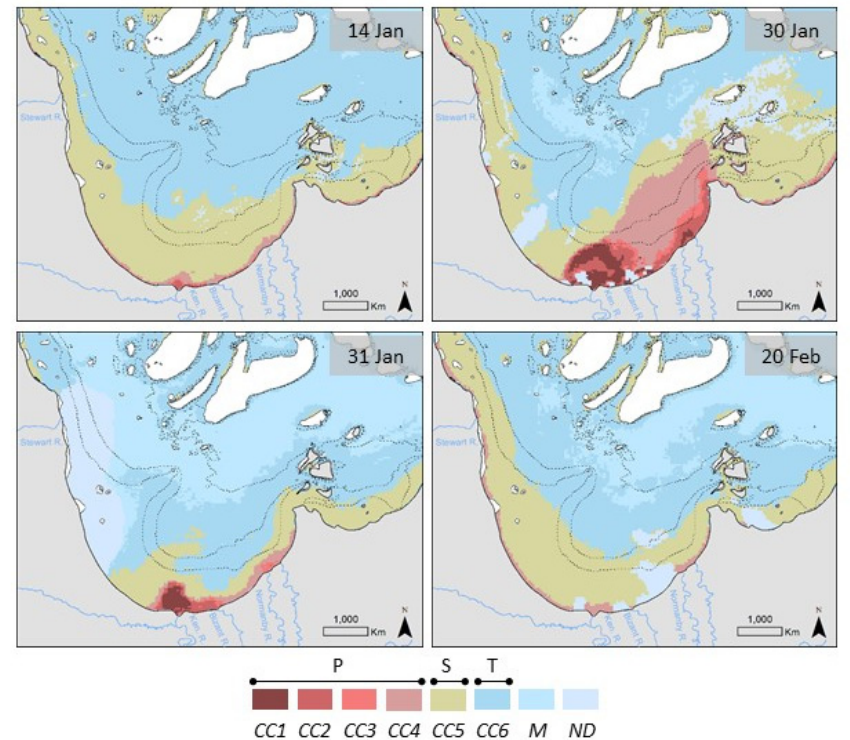
Figure 5. MODIS color-class maps. MODIS satellite images of the region used to map reef optical water types. Water types are classified depending on water color and linked to water quality characteristics: color class 1–4 or CC1–CC4 (enriched in sediment and dissolved organic matter), color class 5 or CC5 (with lower suspended sediment content and usually enriched in dissolved organic matter and phytoplankton), and color class 6 or CC6 (clear waters). M: marine waters, ND: Not Defined (cloud or no